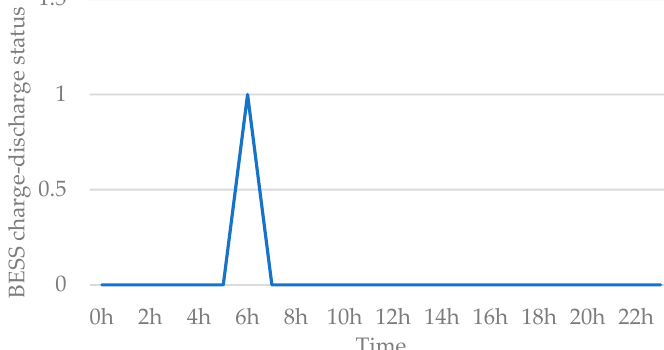
Figure 5. Operational status of the BESS.